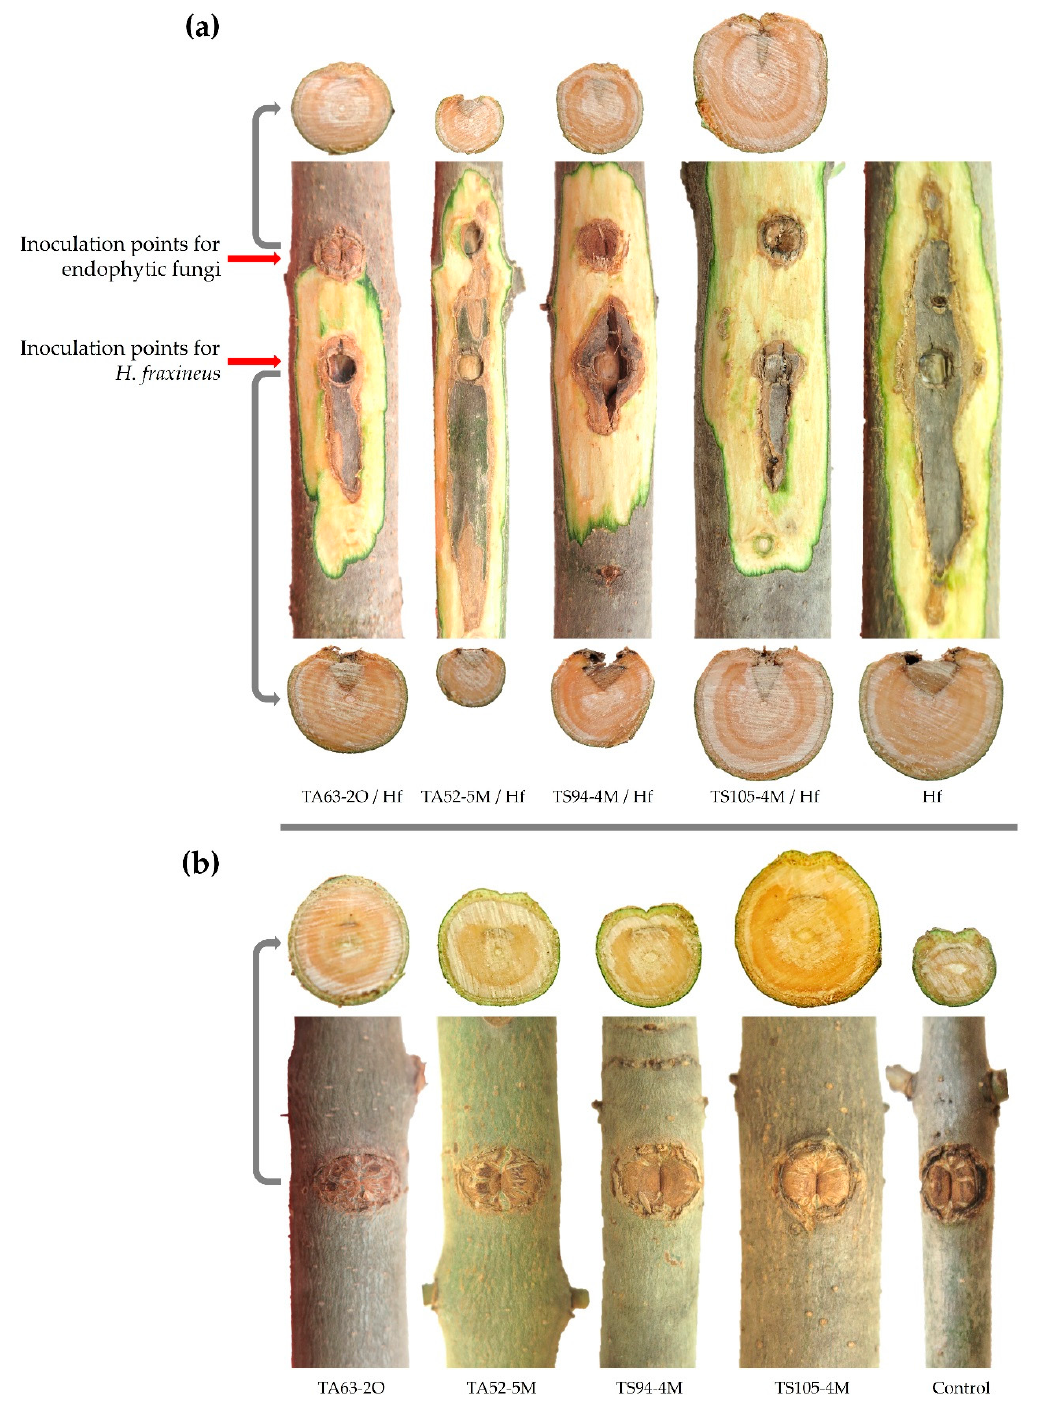
Figure 5. Necrotic lesions on the stems of five-year-old Fraxinus excelsior trees developed 180 days after their artificial inoculation with Hymenoscyphus fraxineus (Hf) and endophytic fungi Didymella macrostoma (TA63-2O), Dothiorella gregaria (TA52-5M), Fusarium lateritium (TS94-4M), and Didymella aliena (TS105-4M): ( a ) necroses developed after inoculation of the bark with H. fraxineus alone (the positive control) or in combination with endophytic fungal isolates including cross-sections through the ash stems at the inoculation points; ( b ) trees recovered from wounds performed on the bark of ash trees during inoculation with endophytic fungal isolates, including non-inoculated tree (the negative control).